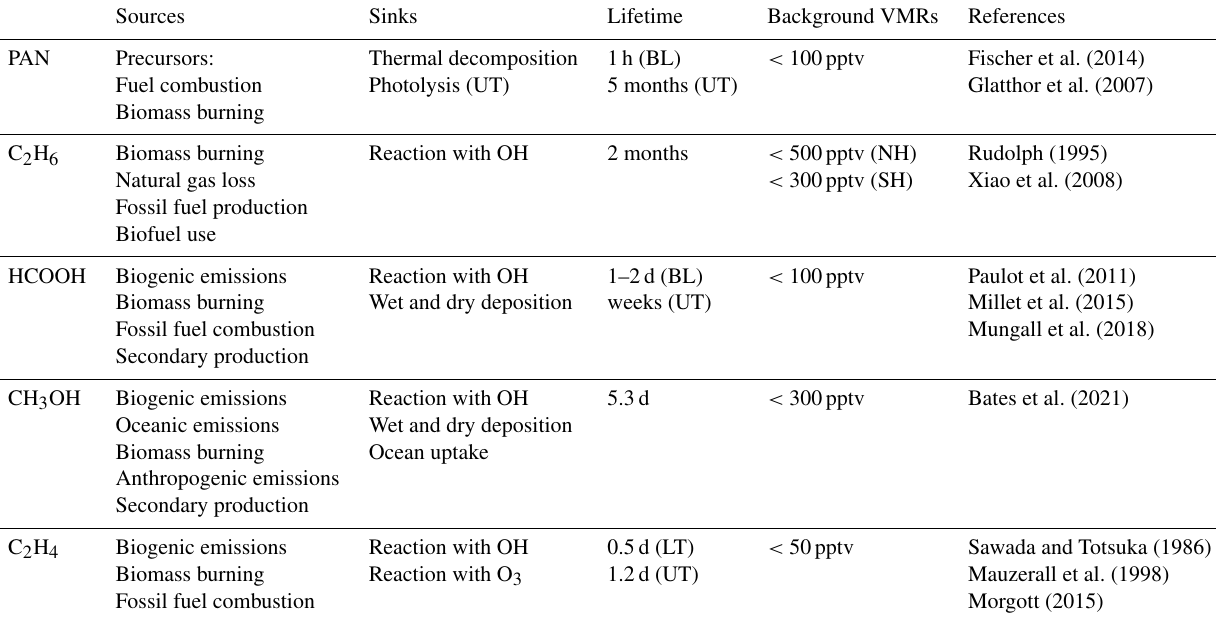
Table 1. Sources, sinks, estimated lifetimes, and approximate upper tropospheric background volume mixing ratios (VMRs) of pollution trace gases PAN, C 2 H 6 , HCOOH, CH 3 OH, and C 2 H 4 which are discussed in this